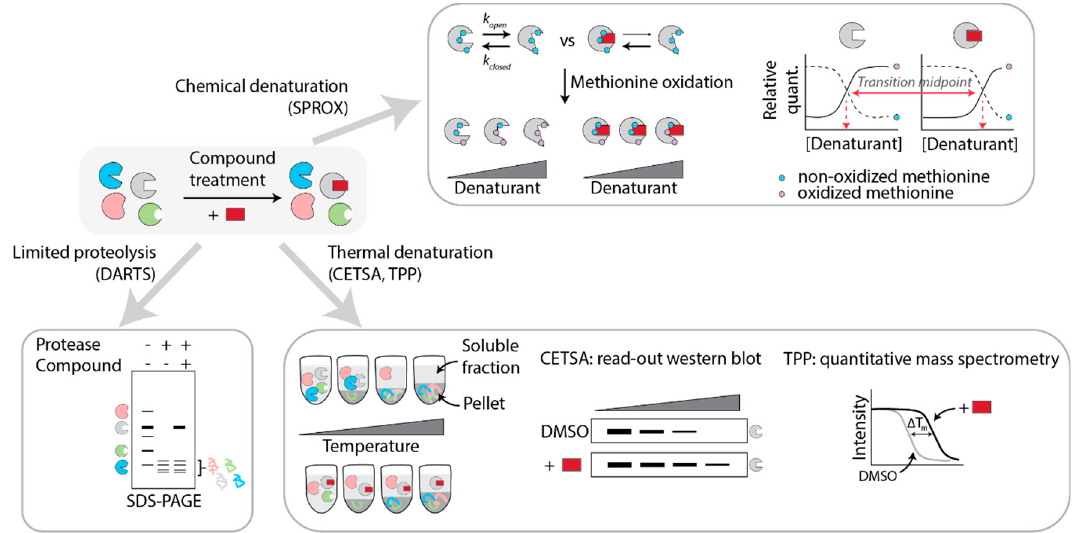
Figure 2. Label-free proteome-based methods for target identification and mode of action studies. Cell